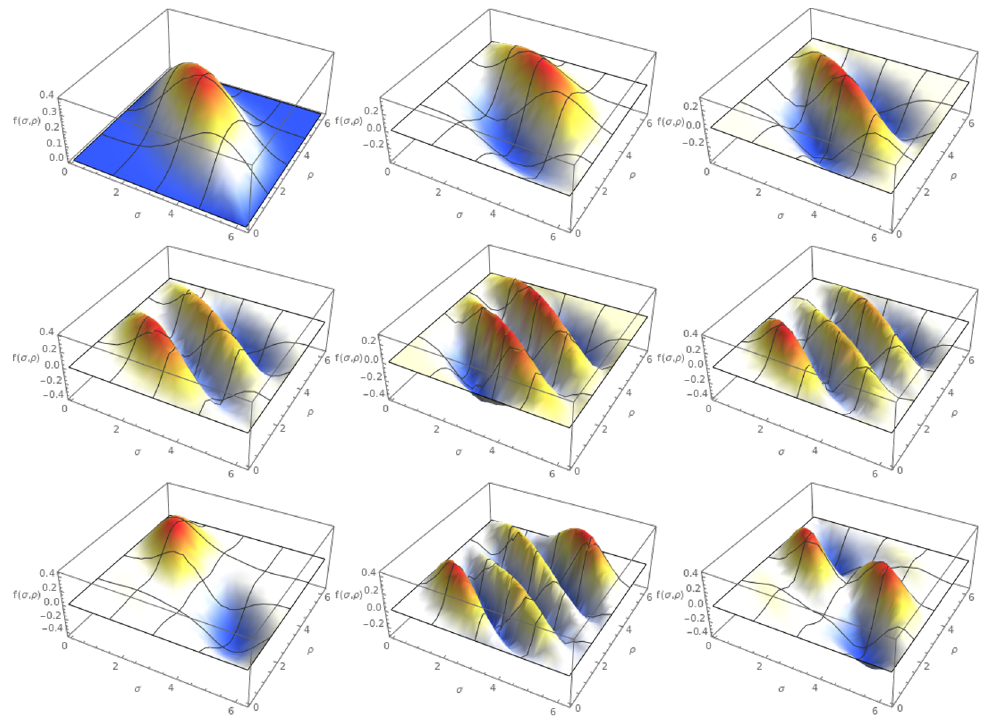
Figure 4 . First nine eigenfunctions of the differential operator for Dirichlet boundary conditions.